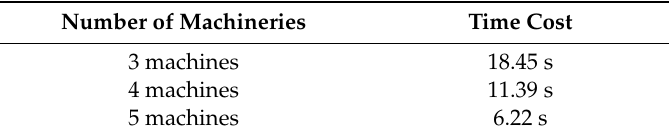
Table 9. Time cost of the proposed scheduling algorithm with 10 jobs.